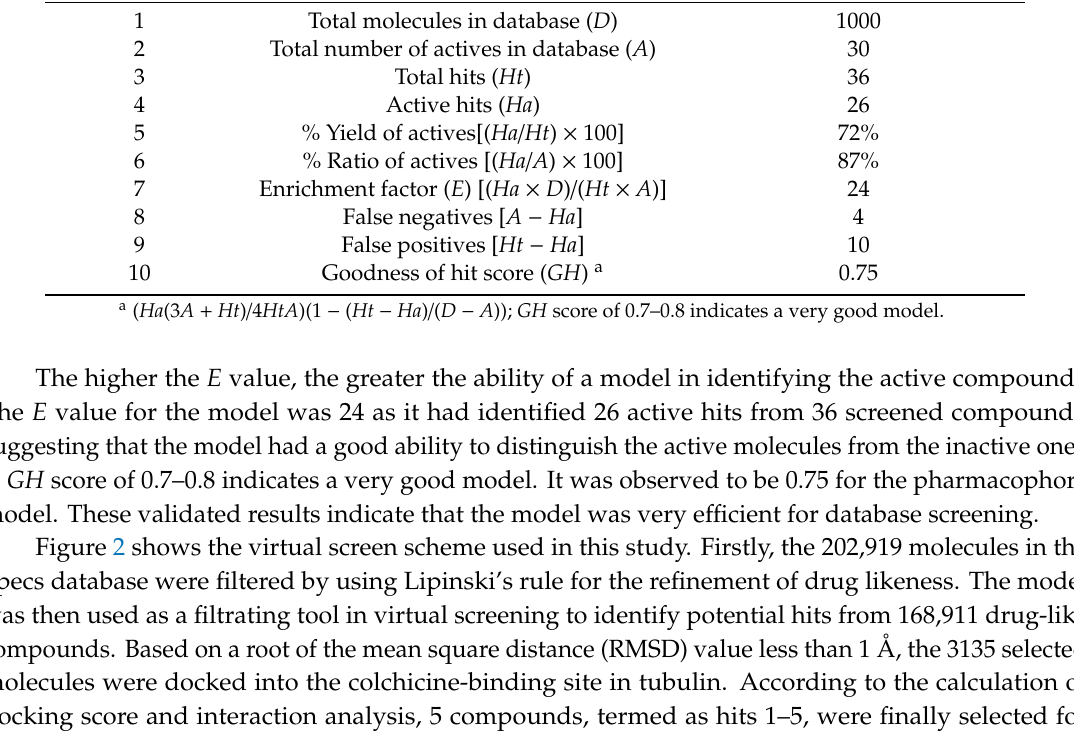
Table 2. Pharmacophore model validation using goodness-of-hit score (GH) score method. Serial No. Parameter Pharmacophore Model 1 Total molecules in database ( D